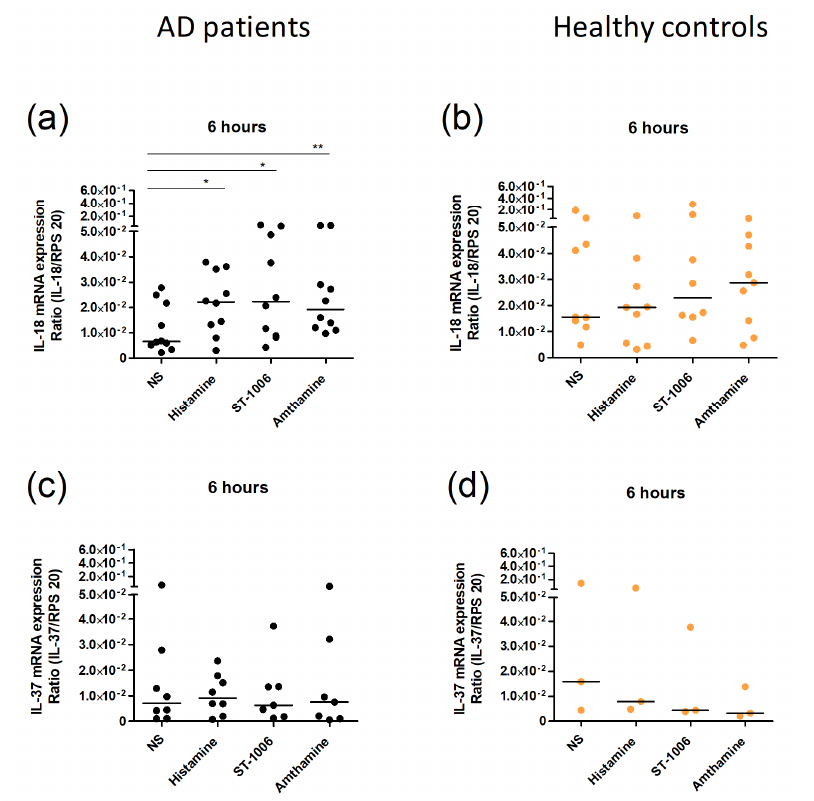
Figure 4. IL-18 and IL-37 mRNA expression after stimulation with histamine, ST-1006, and amthamine in eosinophils. ( a – d ) Purified eosinophils from AD patients (black) and healthy controls (orange) were stimulated with histamine (10 μmol/L), the H 4 R agonist ST-1006 (10 μmol/L), and the H 2 R agonist amthamine (10 μmol/L) for 6 h or were left unstimulated (NS). The expression level of IL-18 ( a , b ) and IL-37 ( c , d ) were measured at mRNA level by real-time PCR. For statistical analysis, a Wilcoxon signed rank test was applied. * p -value < 0.05; ** p -value < 0.1. NS—not stimulated.